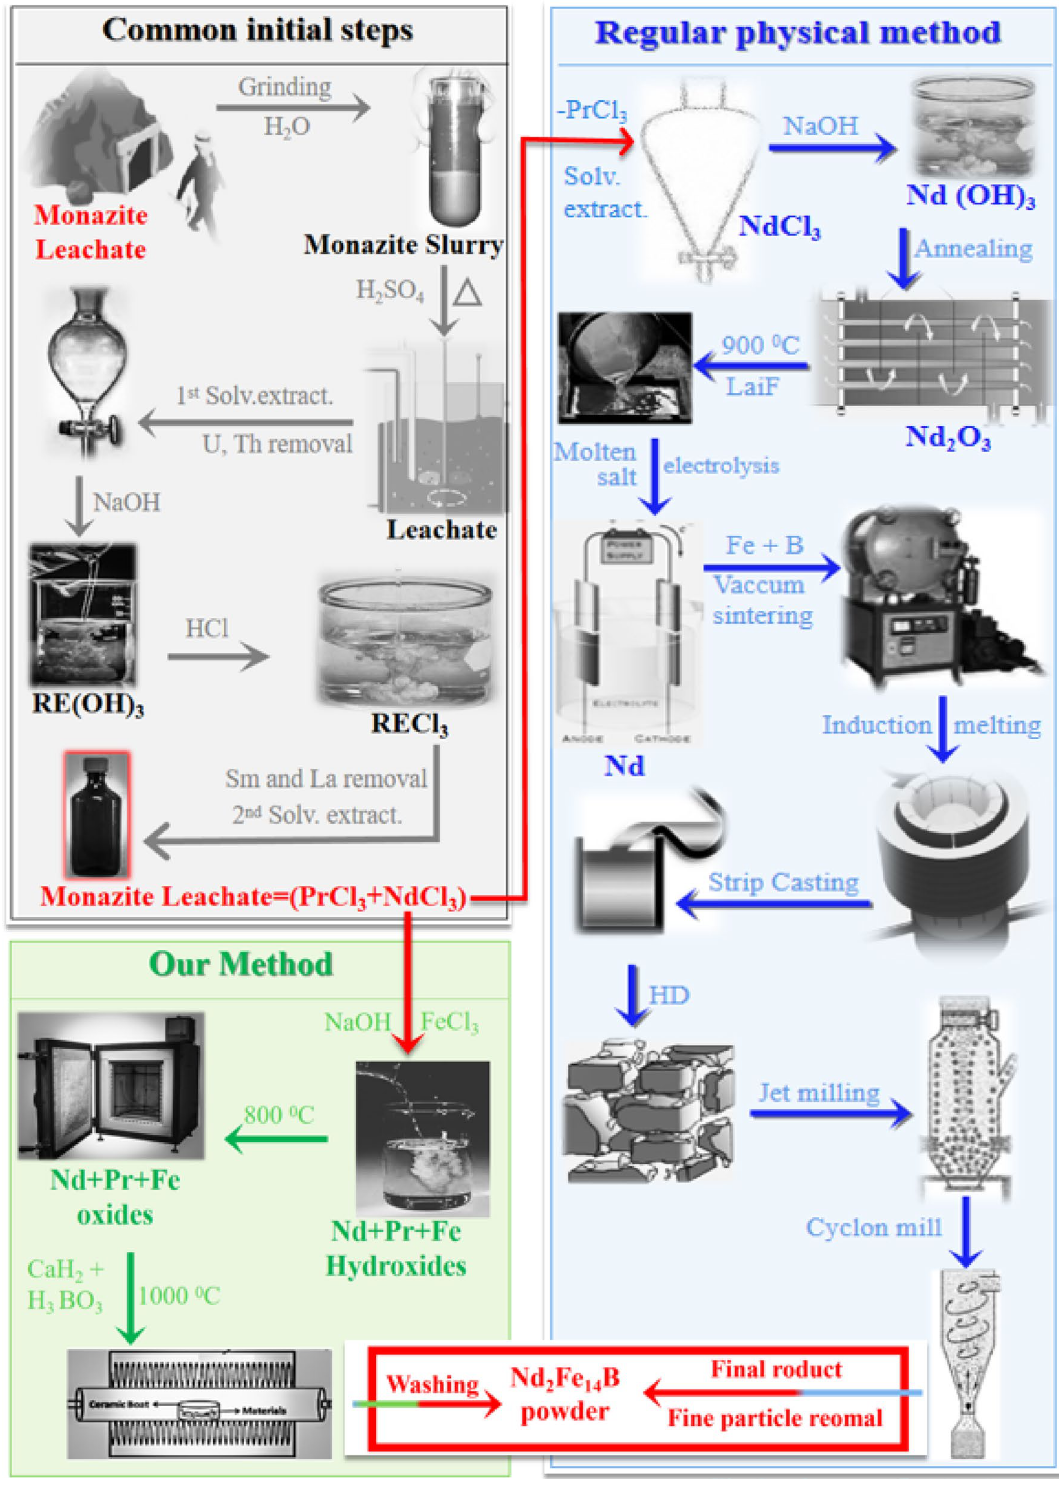
Figure 1. ( a ) Flow chart of our experimental process compared with the regular commercial